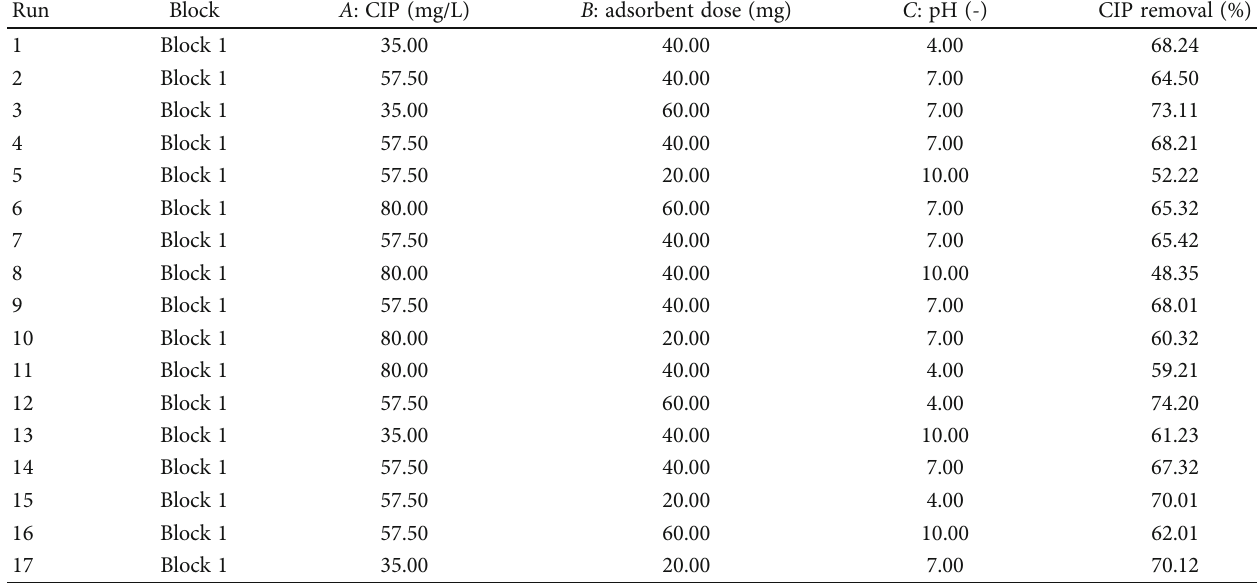
Table 2: The results of the Box-Behnken experimental design